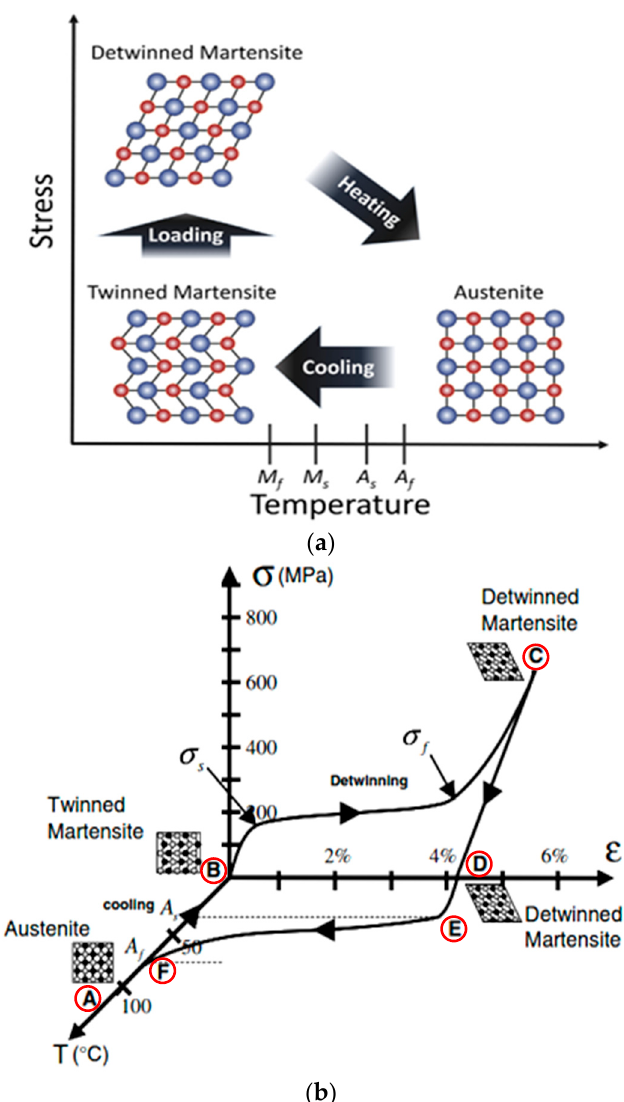
Figure 2. ( a ) Representation of phase transformation in shape memory Ni-Ti [40], and ( b ) Stress-Strain-Temperature graph showing phase transformation in Ni-Ti [41].